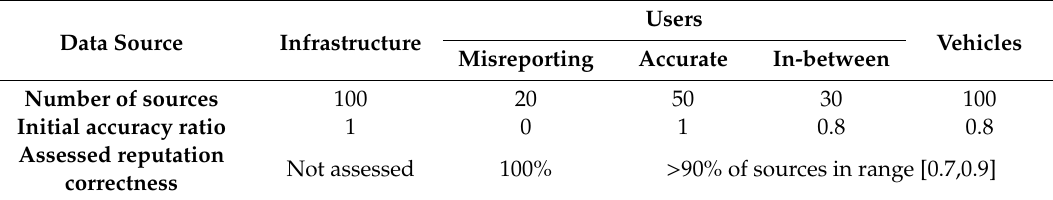
Table 3. Source reputation value assessment